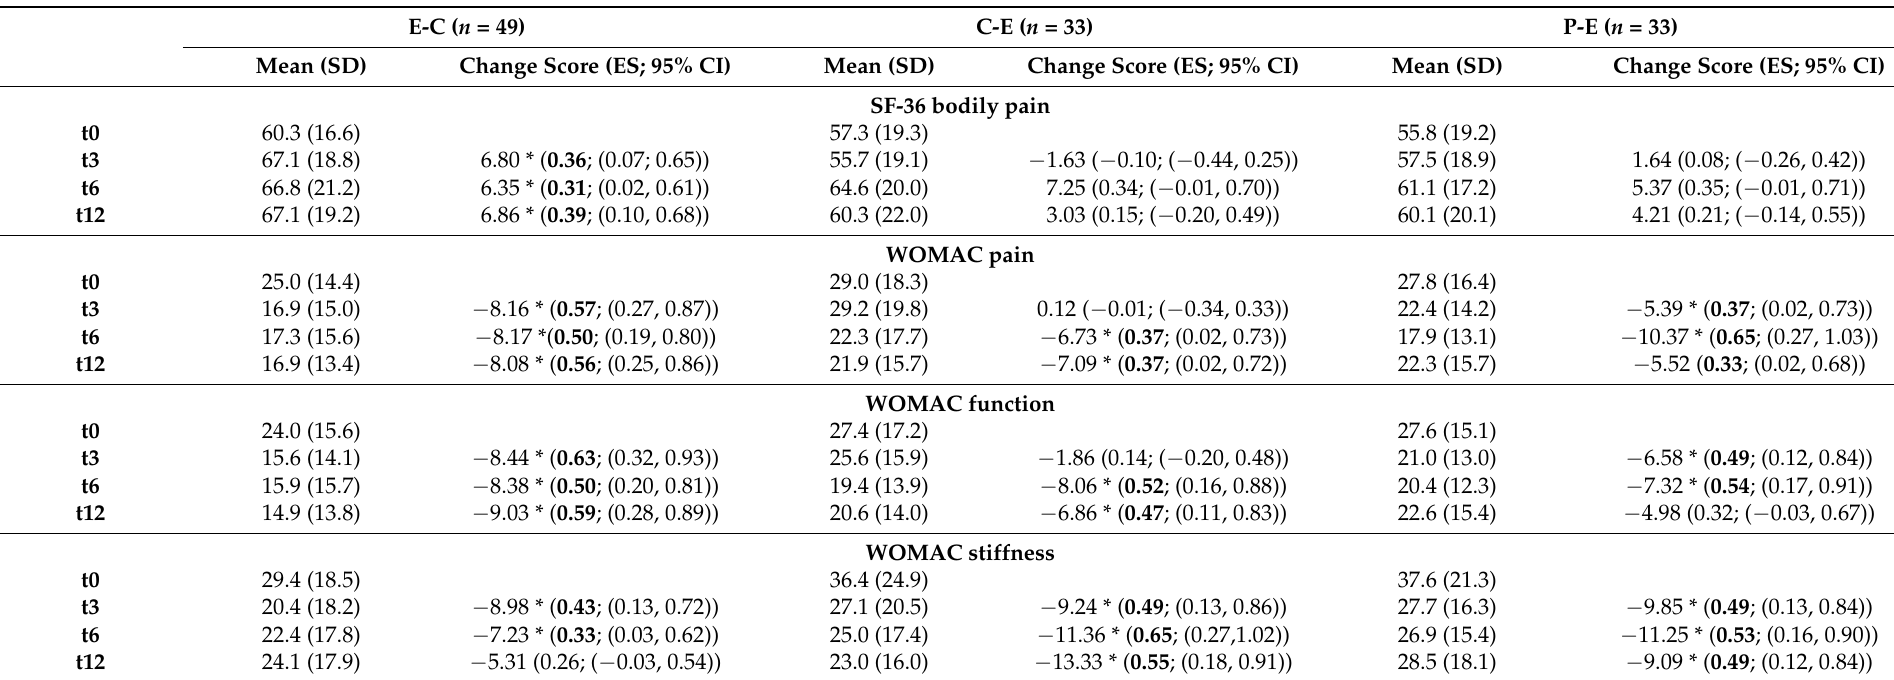
Table 2. Mean (SD), change scores = change from baseline within-group means, effect sizes (Hedges g z [26]), and 95% CIs for clinical outcome measures of finishers ( n =